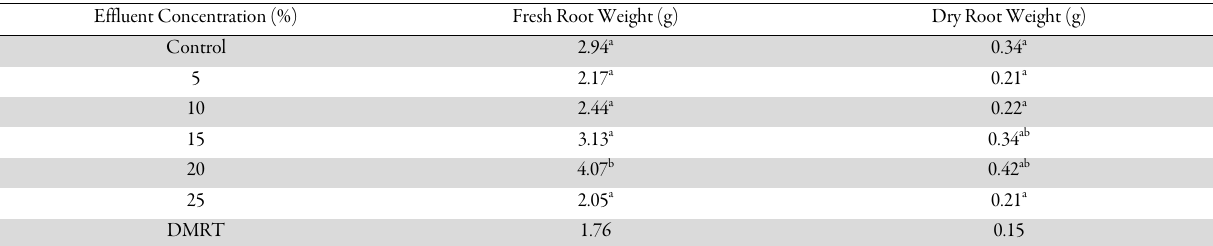
Table 6. Fresh and dry weight of root of Solanum lycopersicum treated with different concentrations of effluent at 16WAP